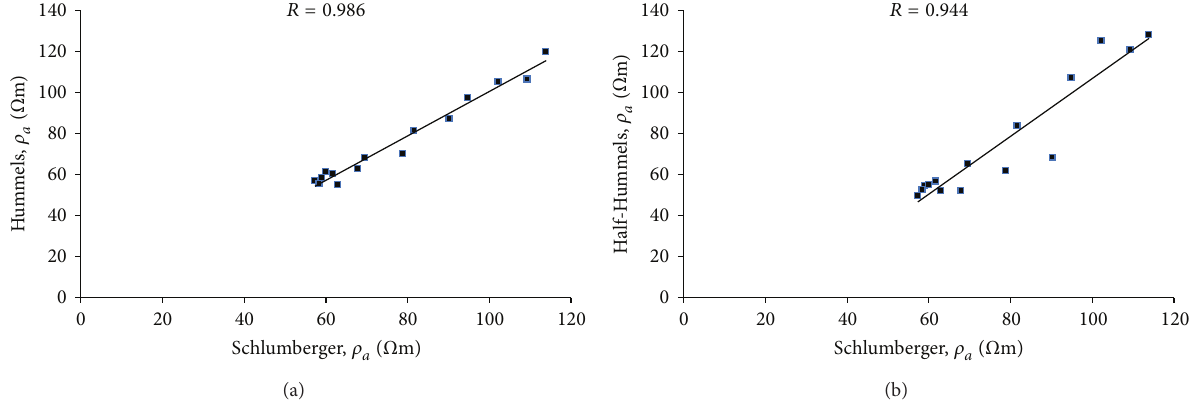
Figure 27: Statistical plot of apparent resistivity data for location 16 (amphibolite) (a) Hummel against conventional Schlumberger (VES) and (b) “Half-Hummel” against conventional Schlumberger